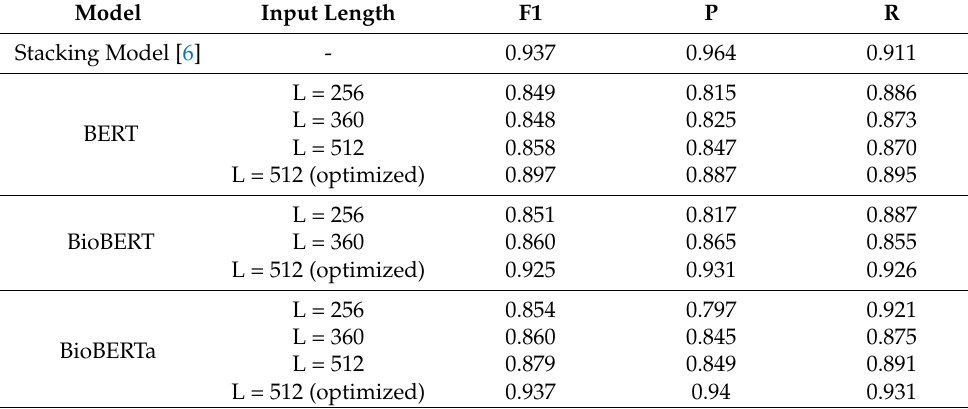
Table 2. Outcome prediction results from three different NLP models and a tabular data-based stacking model as a